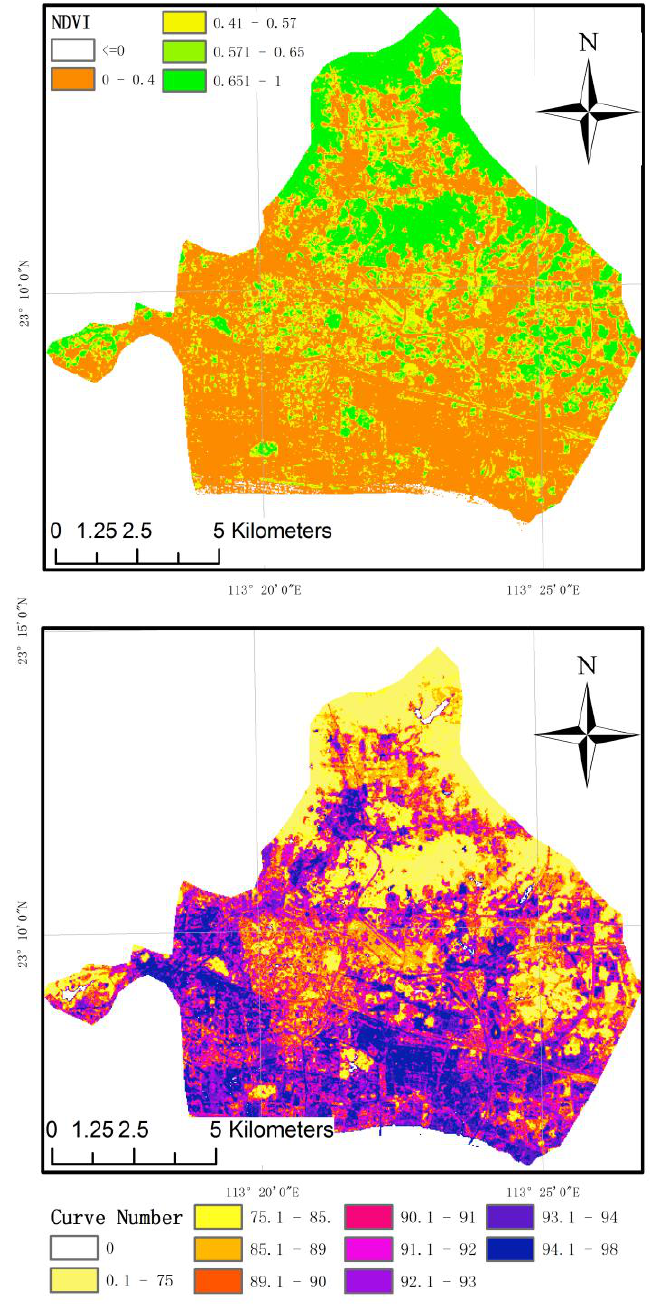
Figure 4. The NDVI and composite CN